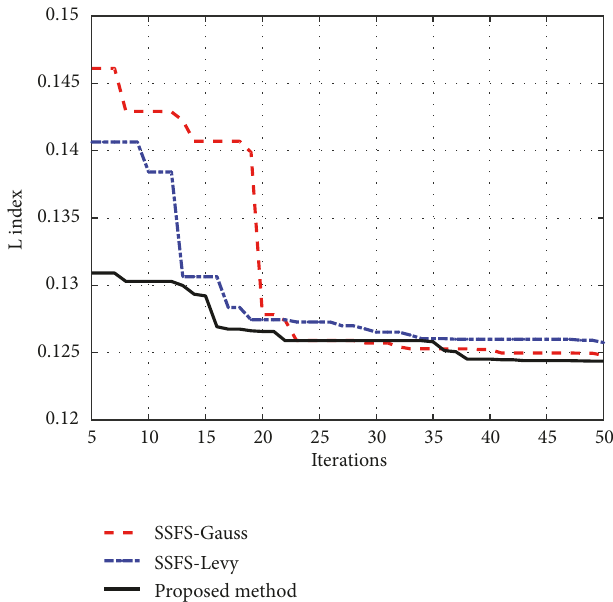
Figure 9: The best run obtained by three methods for L-index optimization of IEEE 30-bus